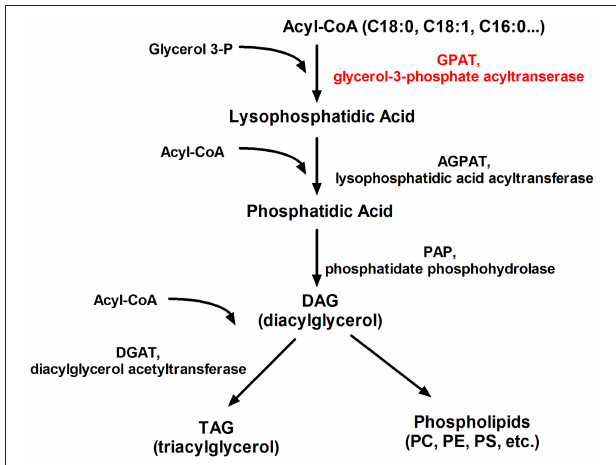
FIGURE 6 | Schematic representation of the glycerolipid metabolism. PC, phosphatidylcholine; PE, phosphatidylethanolamine; PS,